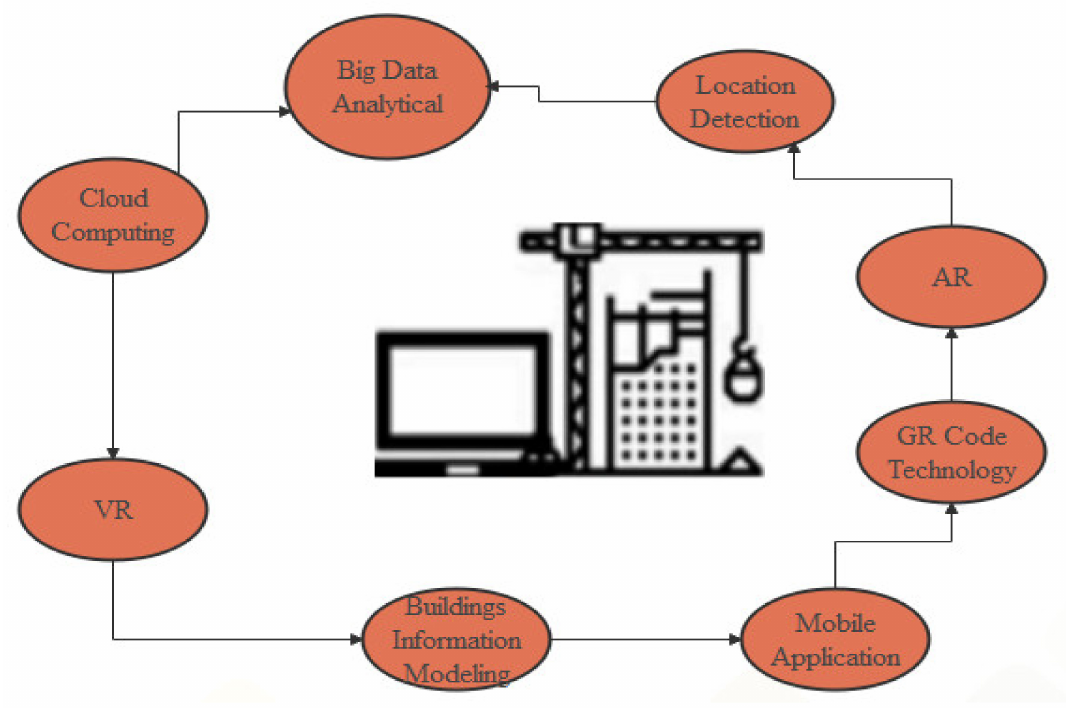
Figure 11. The use of different methods in education